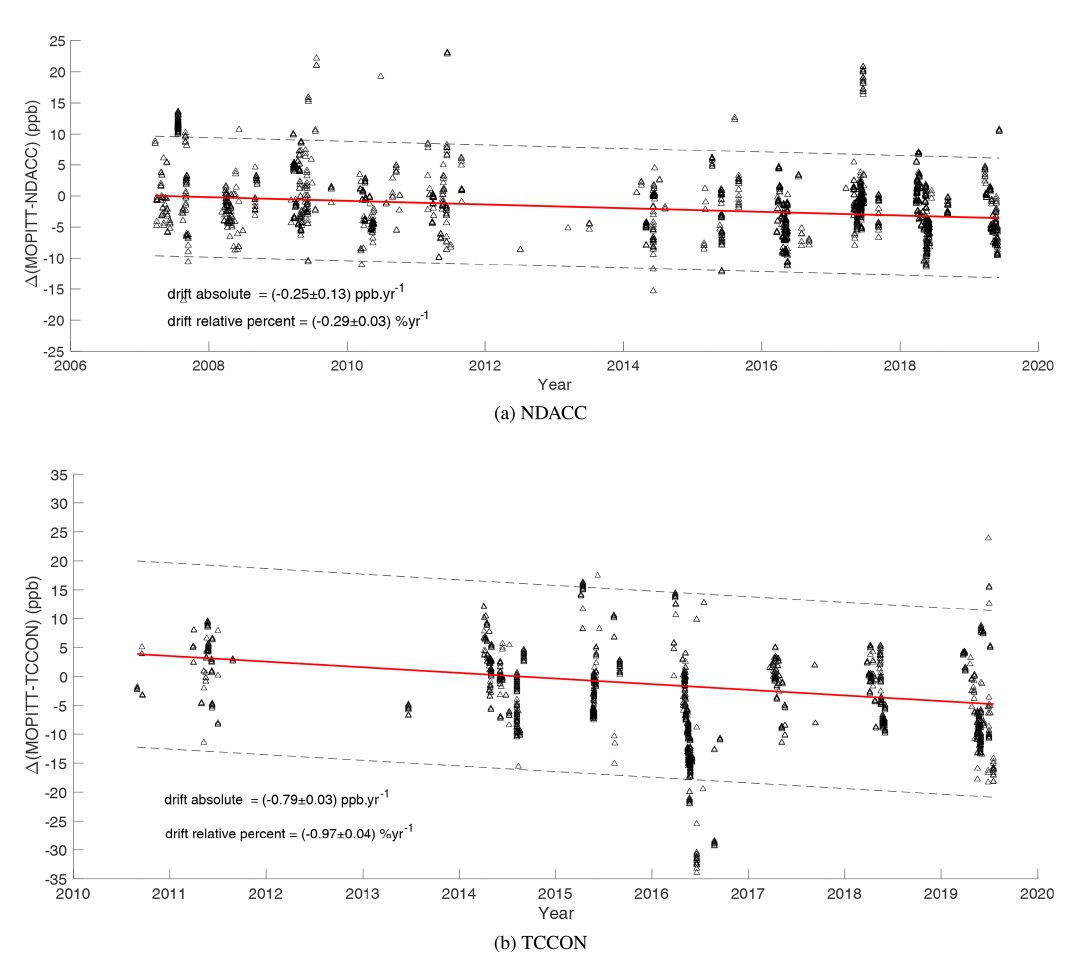
Figure 9. Sample correlation plots for MOPITT TIR pixel 2 CO measurements over land vs. the (a) NDACC and (b) TCCON measurements using bi-square weighted robust fitting. The colors indicate the number of points in each bin to represent the density of points. Dashed black lines are 1:1 reference lines with a slope of 1. Red lines are lines of the linear best fit.